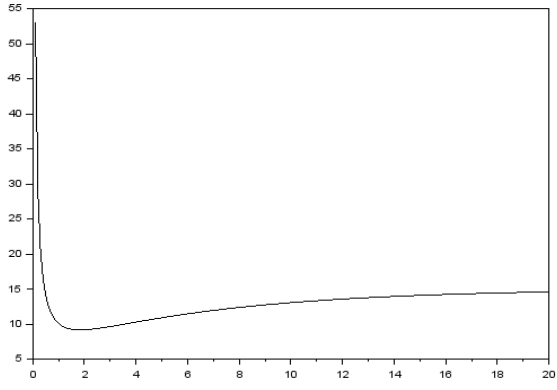
Figure 5. The shape of c a (T) for p  =  =0.2, C I =5, C R =15, C D